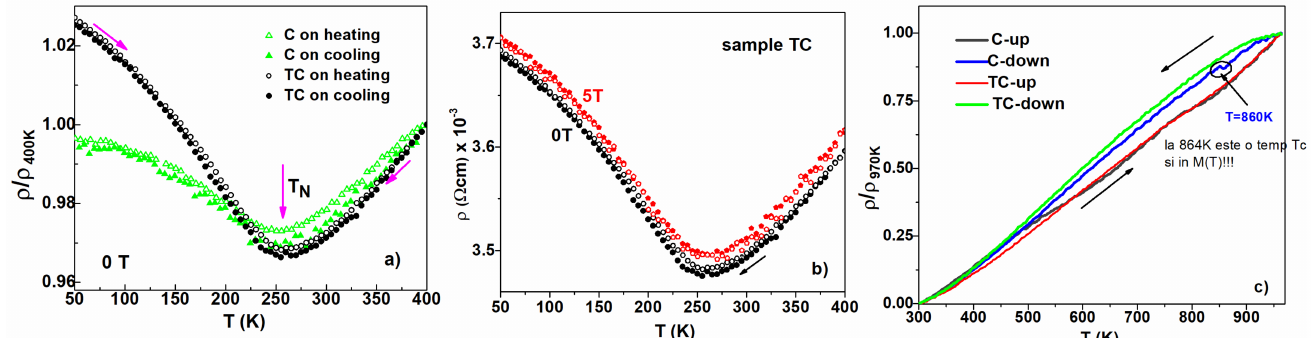
Figure 10. ( a ) normalized temperature dependence of the resistivity for samples C and TC; ( b ) resistivity variation with temperature in zero and 5T; ( c ) the variation of resistance with temperature at high